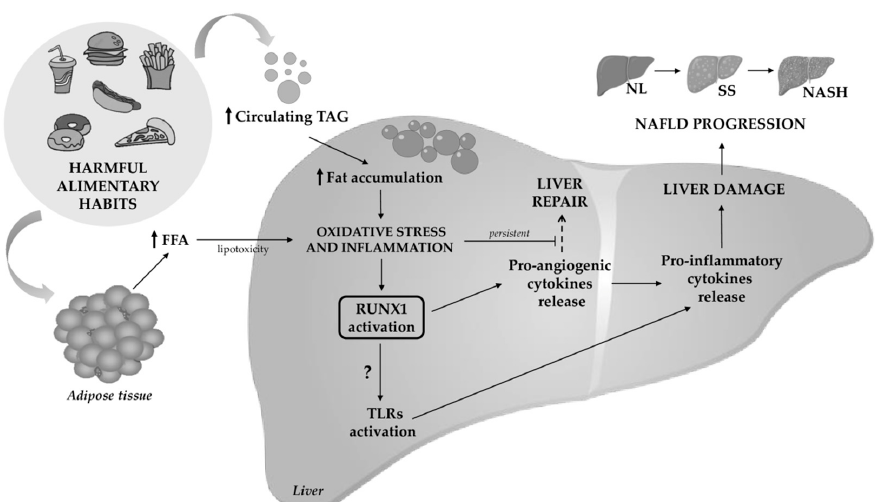
Figure 1. RUNX1 is involved in inflammation-mediated NAFLD. Harmful eating habits lead to high levels of circulating triglycerides (TAG), which accumulate in the liver, causing oxidative stress and inflammation. These two processes activate RUNX1, which turns on the angiogenesis pathway to try to repair injuries. At the same time, there is a growth of the adipose tissue that releases free fatty acids (FFA) that reach the liver, leading to lipotoxicity that promotes inflammation. A persistent inflammation state inhibits the tissue remodeling and promotes the release of pro-inflammatory cytokines, which leads to liver tissue damage and enhances the progression of NAFLD to NASH [13–16,19]. On the other hand, it was also shown that RUNX1 is a positive regulator of TLR4, signaling for the induction of the inflammatory response [21]. TLR are involved in the NAFLD pathogenesis